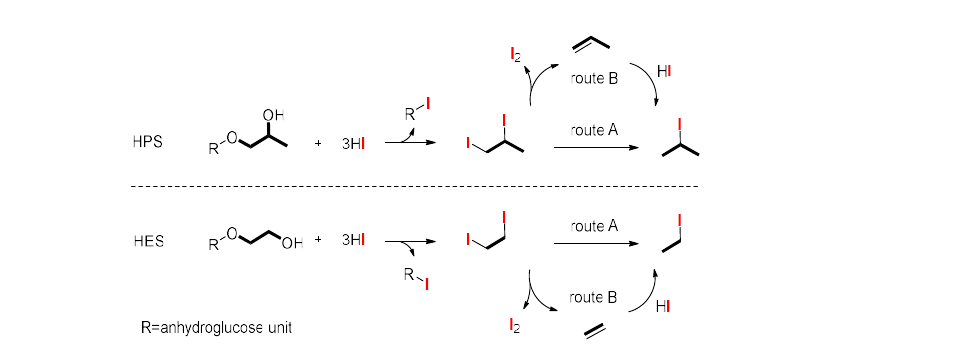
Figure 3. Proposed mechanism for the hydriodic acid decomposition procedure of HPS and HES.